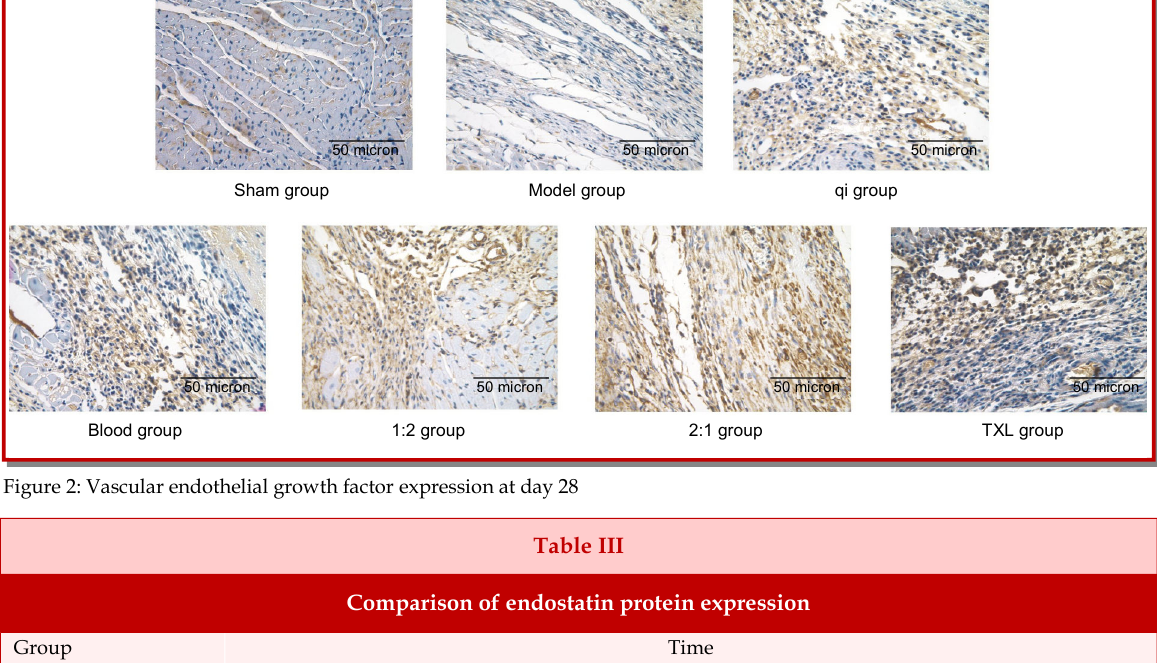
Comparison of endostatin protein expression